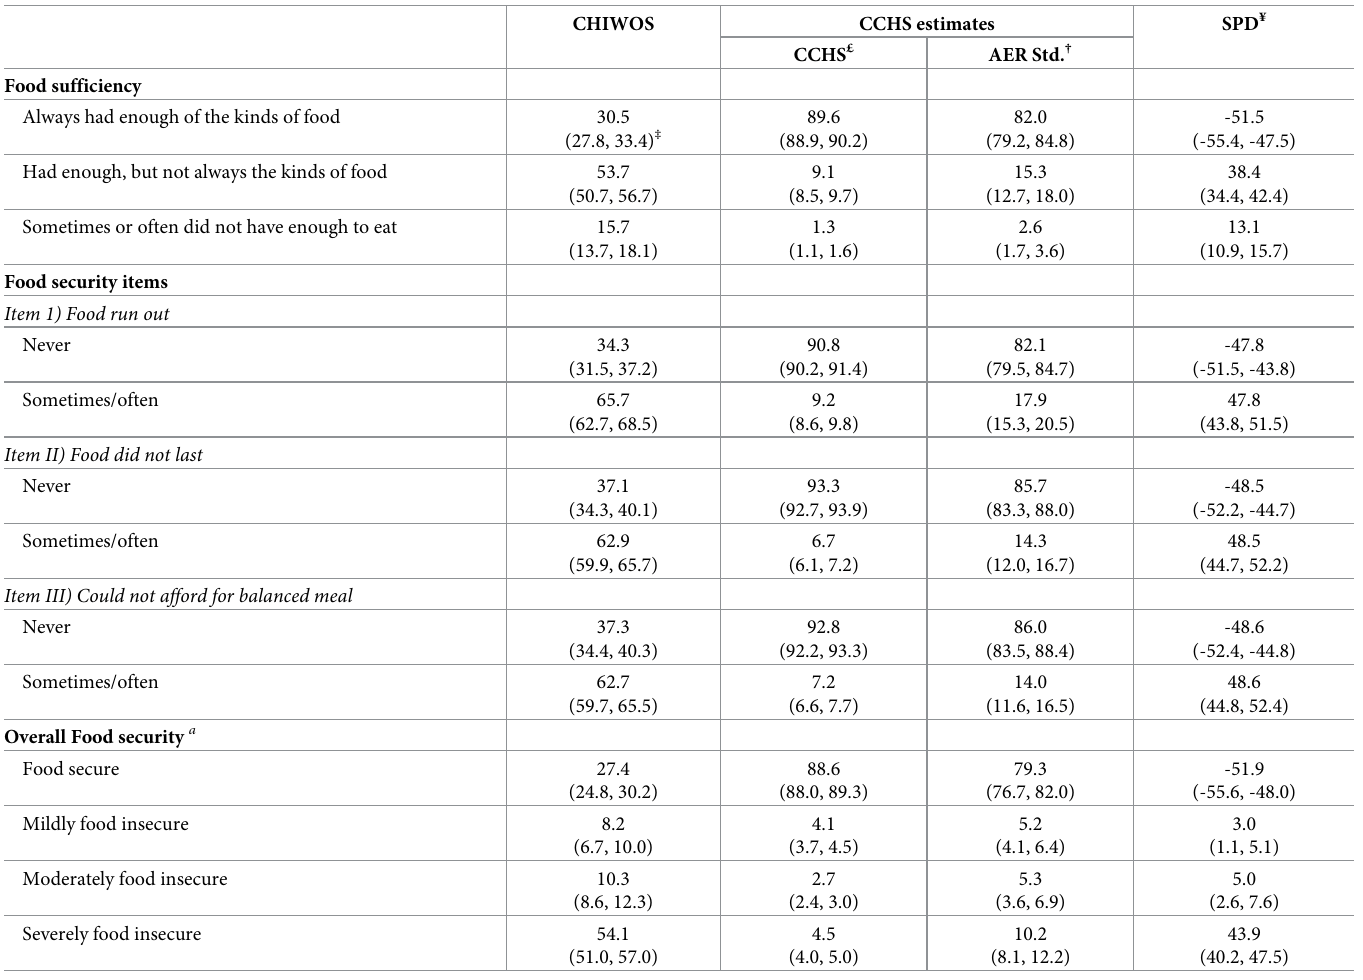
Table 2. Comparing food sufficiency and food security between women living with HIV (CHIWOS; 2013–2015) and the general population of women in Canada (CCHS; 2013–14) � . CHIWOS CCHS estimates SPD